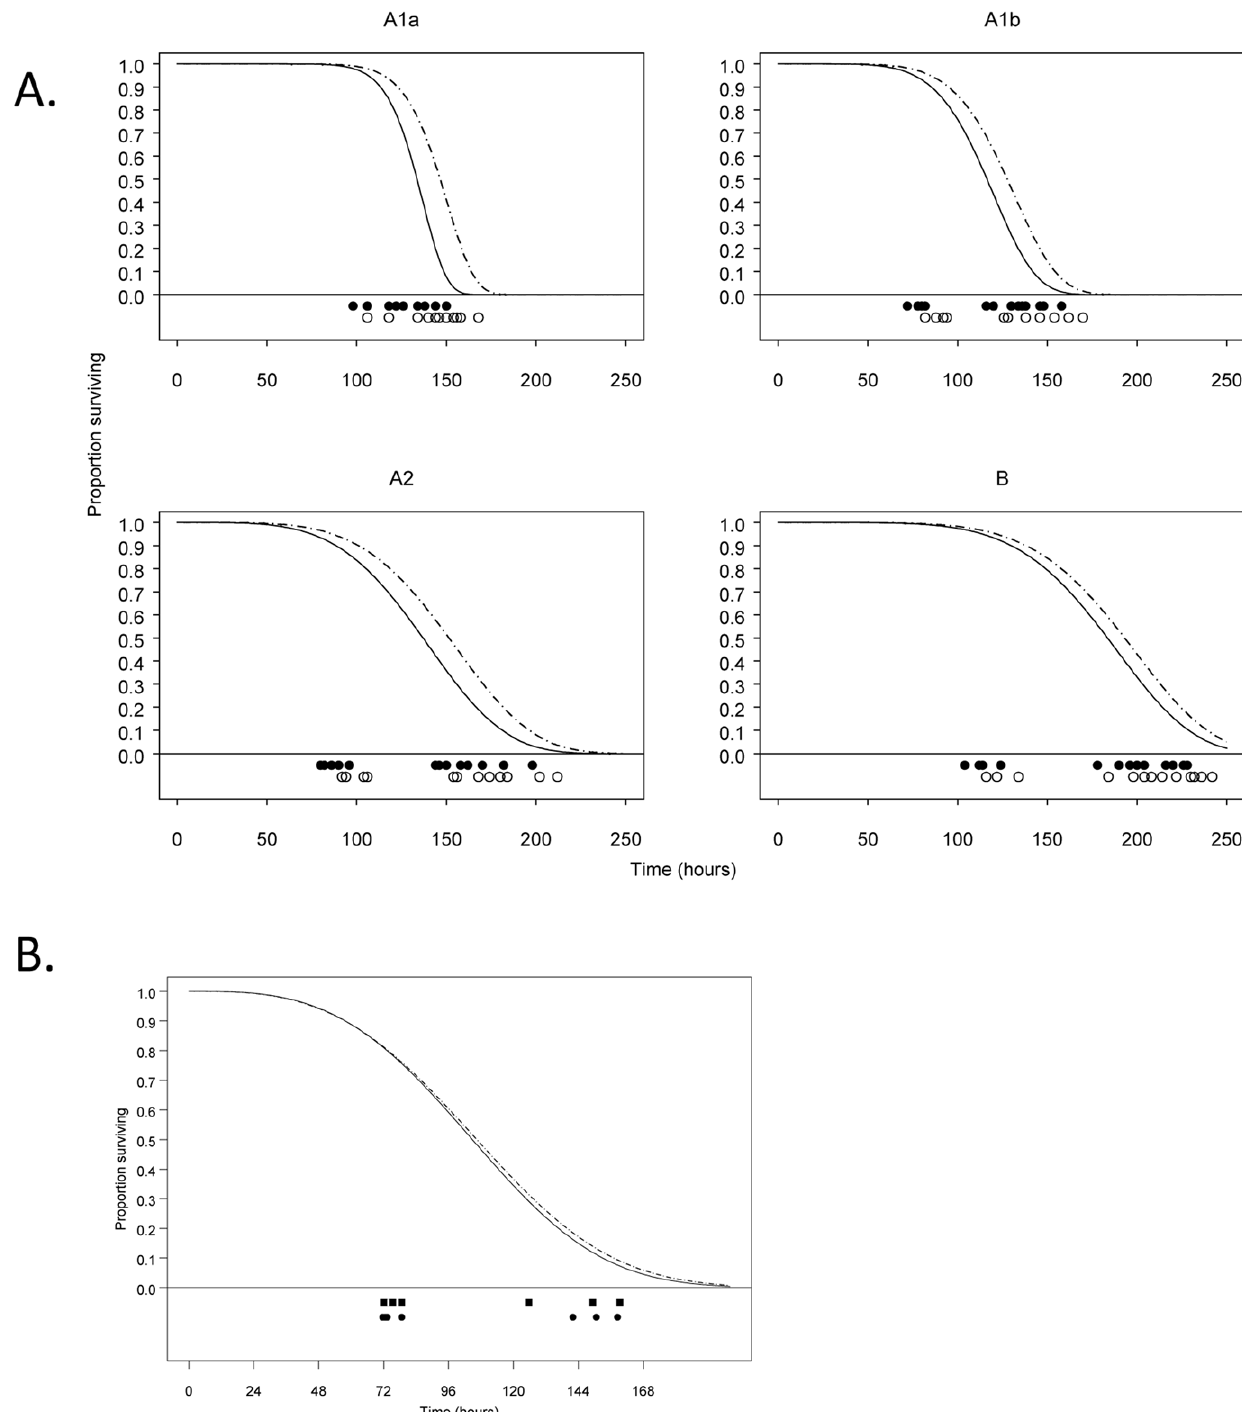
Figure 4. Comparison of fitted survival curves. A) Survival curves (fitted for all data from round 1 and round 2) are shown for mice infected with F. tularensis groups (A1a, A1b, A2 and type B) using drop point (solid lines) and observed time of death (dashed lines). The time at which each mouse expired (solid circles) or reached drop point (open circles) was reached is shown below the graph. B) Survival curve comparison between two infections performed at different times using the same A1b strain MA00-2987. The first MA00-2987 infection is denoted as ( NNN — NNN ). During this infection, mice were allowed to expire and drop point was subsequently identified and used as the endpoint for generating the survival curve. The second MA00-2987 infection is denoted as (——). Mice were euthanized at drop point during this infection for generation of the survival curve. The time at which each mouse reached drop point is shown below the graph as squares (1 st round) or circles (2 nd round).